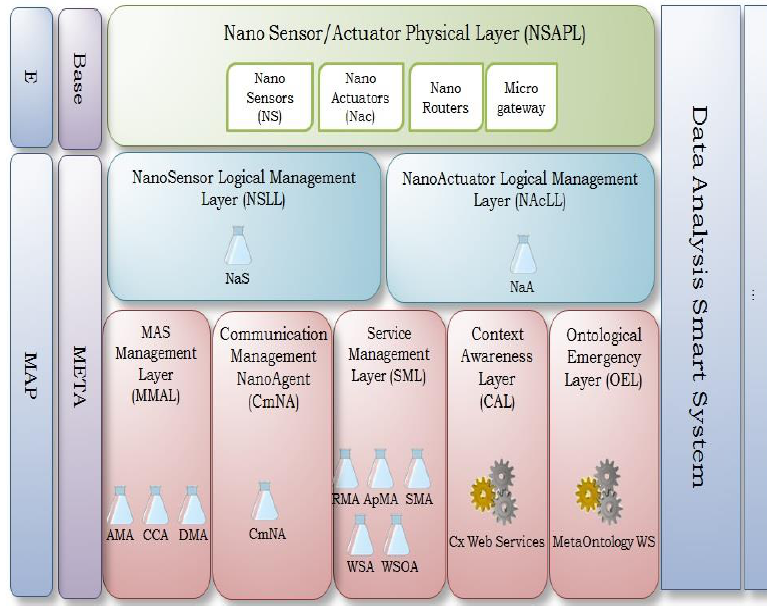
Figure 1. ARMNANO middleware [2].